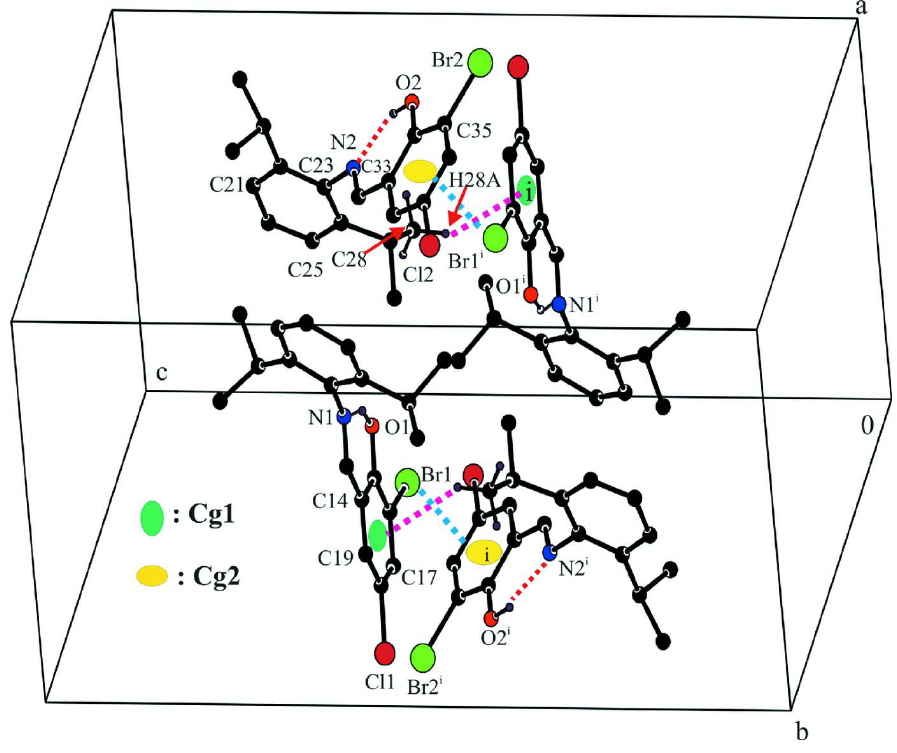
Figure 2 C—H··· π , C—Br··· π and O—H···N interactions (dotted lines) in the title compound. Cg denotes the ring centroid. [Symmetry code: (i) -x+1, -y+1,